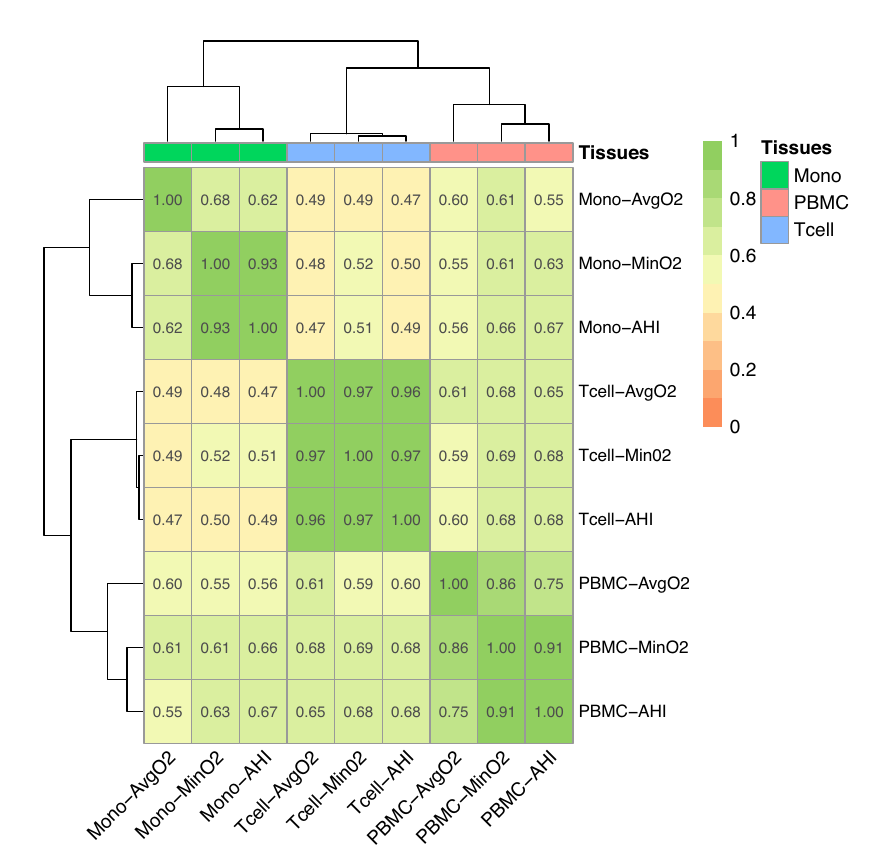
Fig. 1 Spearman correlations between estimated log-fold changes in gene expression across SDB phenotypes and blood cell types without BMI adjustment in MESA. Heatmap illustrating the Spearman correlations of log-fold change of transcript expression by tissue type (monocytes, T-cells, PBMCs) and SDB phenotype (AvgO2, MinO2, AHI) in MESA. Correlations were computed over genes with FDR p < 0.1. Color legend portrays Spearman R 2 (no/weak correlation = light yellow; complete/strong correlation = green). Estimated AHI effect sizes were fl ipped prior to computation of correlations